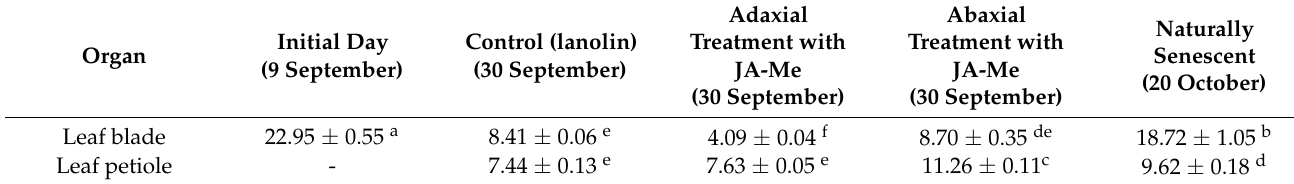
Table 1. Effects of methyl jasmonate (JA-Me) applied to the adaxial and the abaxial sides of the leaf blade on the contents (mg/g DW) of phosphoric acid in leaf blades and petioles of G. biloba . Mean results ± SD followed by the same letter were not significantly different ( p < 0.05) according to Tukey’s